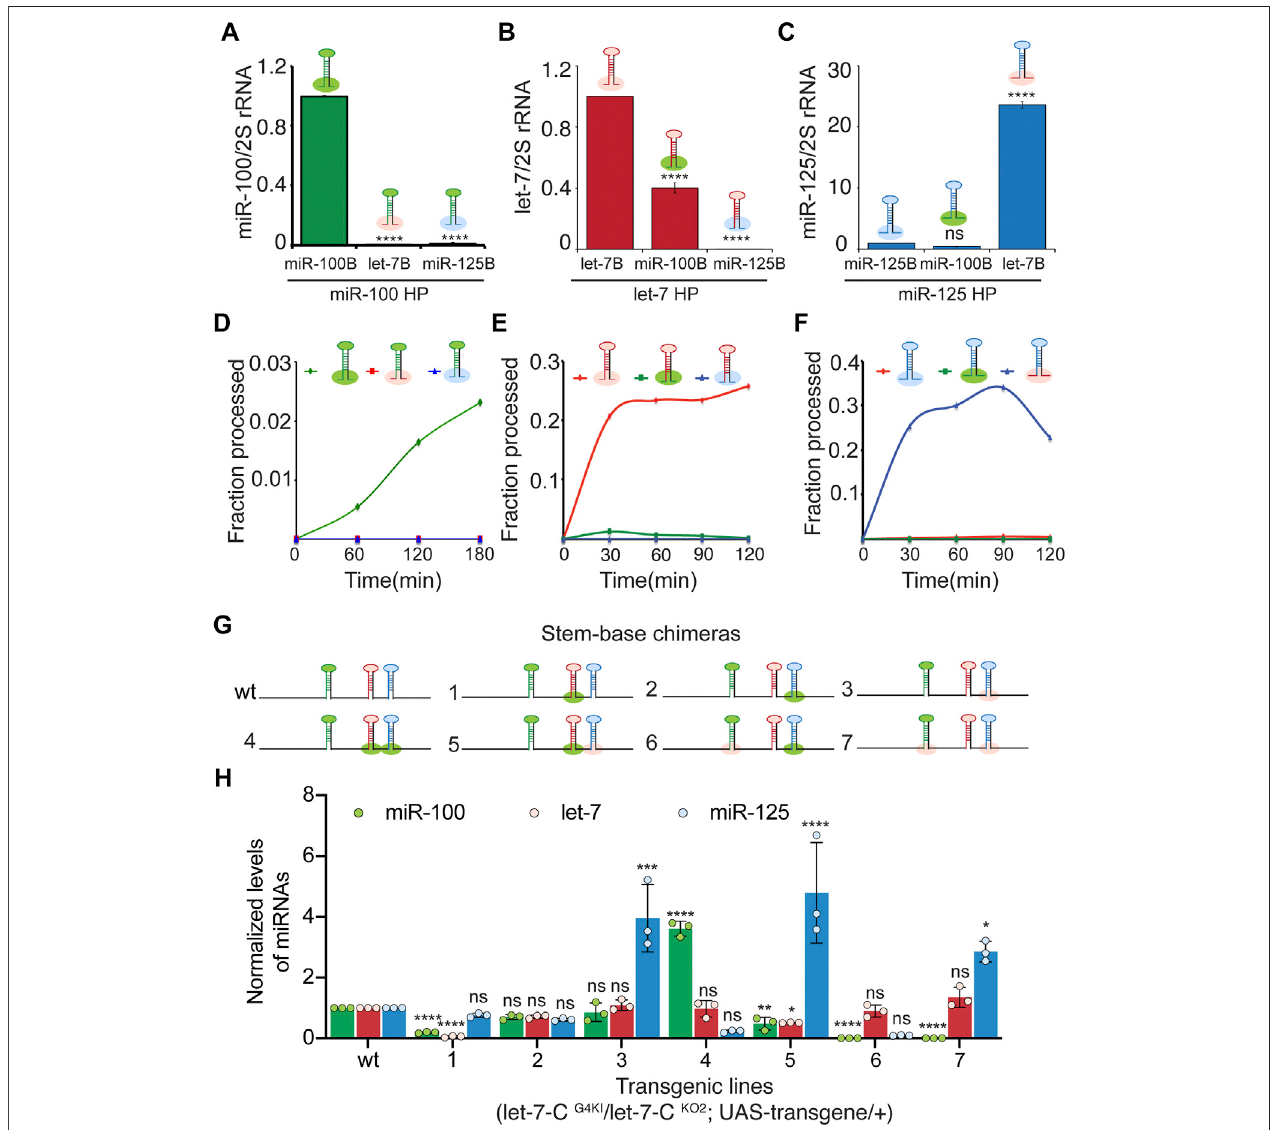
FIGURE4| Thebasalstemsequencesregulatetheexpressionandfunctionofthe let-7-C miRNAs. (A) ExpressionofmiR-100intransgeniclinesexpressing UASpri - miR-100, UASpri-miR- 100Hlet -7B , andUASpri-mir-100HmiR-125B underthecontrolof let-7-C Gal4knock-indriver( G4KI )asdeterminedbyTaqmanmiRNAassays.Dataarerepresentedas mean±SD, n =3. p -valuecalculatedbyordinaryone-wayANOVAis7.57E-13. (B) Expressionoflet-7intransgeniclinesexpressing UASpri - let-7,UASpri-let-7HmiR-100B,andUAS pri-let-7HmiR-125B under the control of let-7-C Gal4 knock-in driver ( G4KI ) as determined by Taqman miRNA assays. Data are represented as mean ± SD, n = 3. p -value calculated by ordinary one-way ANOVA is 1.15E-08. (C) Expression of miR-125 in transgenic lines expressing UAS pri-miR-125, UAS pri-miR-125HmiR-100B, and UAS pri-miR- 125Hlet-7B under the control of let-7-C Gal4 knock-in driver ( G4KI ) as determined by Taqman miRNA assays. Data are represented as mean ± SD, n = 3. p -value calculated by ordinaryone-wayANOVAis7.20E-10. (D – F) Linegraphdepictingkineticsofprocessingofwildtype(greenline)andchimericpri-miR-100(blueandred) (D) ,wild type(redline)and chimeric pri-let-7 (green and blue) (E) , and wild type (red line) and chimeric pri-miR-125 (blue and green) (F) . (D – F) Chimeric and wild type transcripts were subjected to Drosha cleavage,andthefractionofprocessedpre-miRNAwascalculatedastheratioofpre/pre+pri. (G) SchematicrepresentationofUAS let-7-C chimerasthataredescribedinpanel (H) . (H) Expression of miR-100 (green bar), let-7 (red bar), and miR-125 (blue bar) in transgenic lines expressing UAS let-7-C cDNA wild type and chimeras under the control of let-7-C Gal4knock-in driver ( G4KI ) asdetermined by Taqman miRNAassays.TotalRNAwasextracted from adult fl iesthatwerein atransheterozygote let-7-C nullmutantofthefollowing genotype: let-7-C GKI / let-7-C KO2 ; UAStransgene/+ .2SrRNAwasusedasacontrolfornormalization.Dataarerepresentedasmean±SD, n =3. p -valuecalculatedbyordinaryone- wayANOVAformiR-100is1.22 E-13;forlet-7is6.36E-06;andformiR-125is1.06E-06.Adjusted p -valuesafterapplyingBonferroni ’ scorrectionarerepresentedinthe fi gurepanel andweusedan α levelof0.05toassessstatisticalsigni fi cance.Genotypeofstrainsused: (4A)w 1118 ;let-7-C GKI /let-7-C KO2 ,P{neoFRT}40A;{w+,UASmiR-100}VK00033/+;w 1118 ; let-7-C GKI /let-7-C KO2 ,P{neoFRT}40A;{w+,UASmiR-100Hlet-7B}VK00033/+ ; w 1118 ;let-7-C GKI /let-7-C KO2 ,P{neoFRT}40A;{w+,UASmiR-100HmiR-125B}VK00033/+;(4B)w 1118 ; let-7-C GKI /let-7-C KO2 , P{neoFRT}40A; {w+, UASlet-7} VK00033/+; w 1118 ; let-7-C GKI /let-7-C KO2 , P{neoFRT} 40A ; {w+, UASlet-7HmiR-100B} VK00033/+; w 1118 ; let-7-C GKI /let-7- C KO2 ,P{neoFRT}40A;{w+,UASlet-7HmiR-125B}VK00033/+;(4C)w 1118 ;let-7-C GKI /let-7-C KO2 ,P{neoFRT}40A;{w+,UASmiR-125}VK00033/+;w 1118 ;let-7-C GKI /let-7-C KO2 ,P {neoFRT} 40A ; {w+, UAS miR-125HmiR-100B} VK00033/+; w 1118 ; let-7-C GKI / let-7-C KO2 , P{neoFRT} 40A ; {w+, UAS miR-125Hlet-7B}VK00033/+;(4I) w 1118 ; let-7-C GKI /let-7-C KO2 , P {neoFRT}40A; {w+, UAS let-7-C miR-100, let-7, miR-125 } VK00033/+; w 1118 ; let-7-C GKI /let-7-C KO2 , P{neoFRT}40A; {w+, UAS let-7-C miR-100, let-7HmiR-100B, miR-125 } VK00033/+ ; w 1118